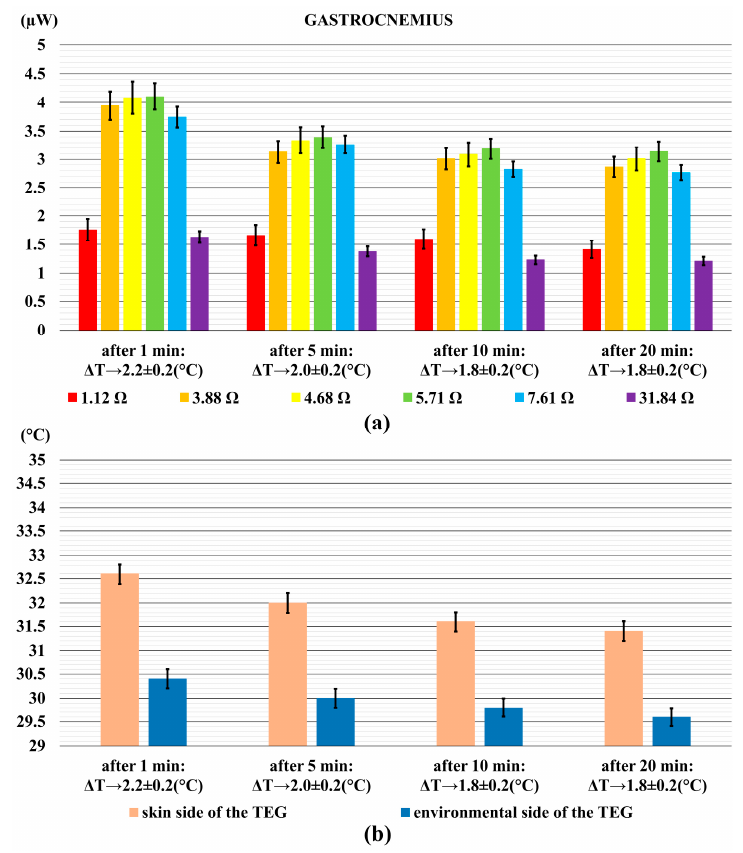
Figure 7. The power output generated by the TEG on the calf, (gastrocnemius muscle) ( a ); and the relative temperature difference ( b ). Error bars represent standard deviations.